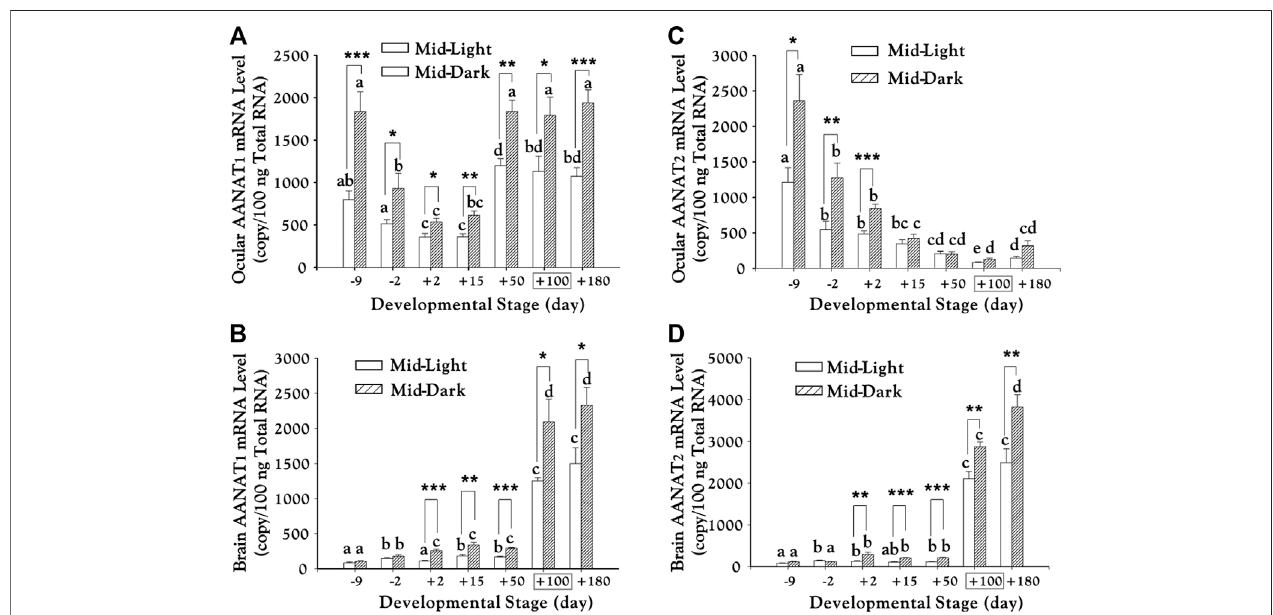
FIGURE7| Transcriptionof aanat1 and aanat2 mRNAsintheeye (A – C) andbrain (B – D) ofchumsalmon(adoptedfromShietal.,2004).Juvenilesbegintomigrate downstream from day +100 (boxed). Duncan ’ s multiple range test (different letters show p < 0.05) and Student ’ s t test (*, p < 0.05; **, p < 0.01; ***, and p < 0.001) were used to compare the signi fi cance between mid-light or mid-dark values at different developmental stages and within the same date, respectively.